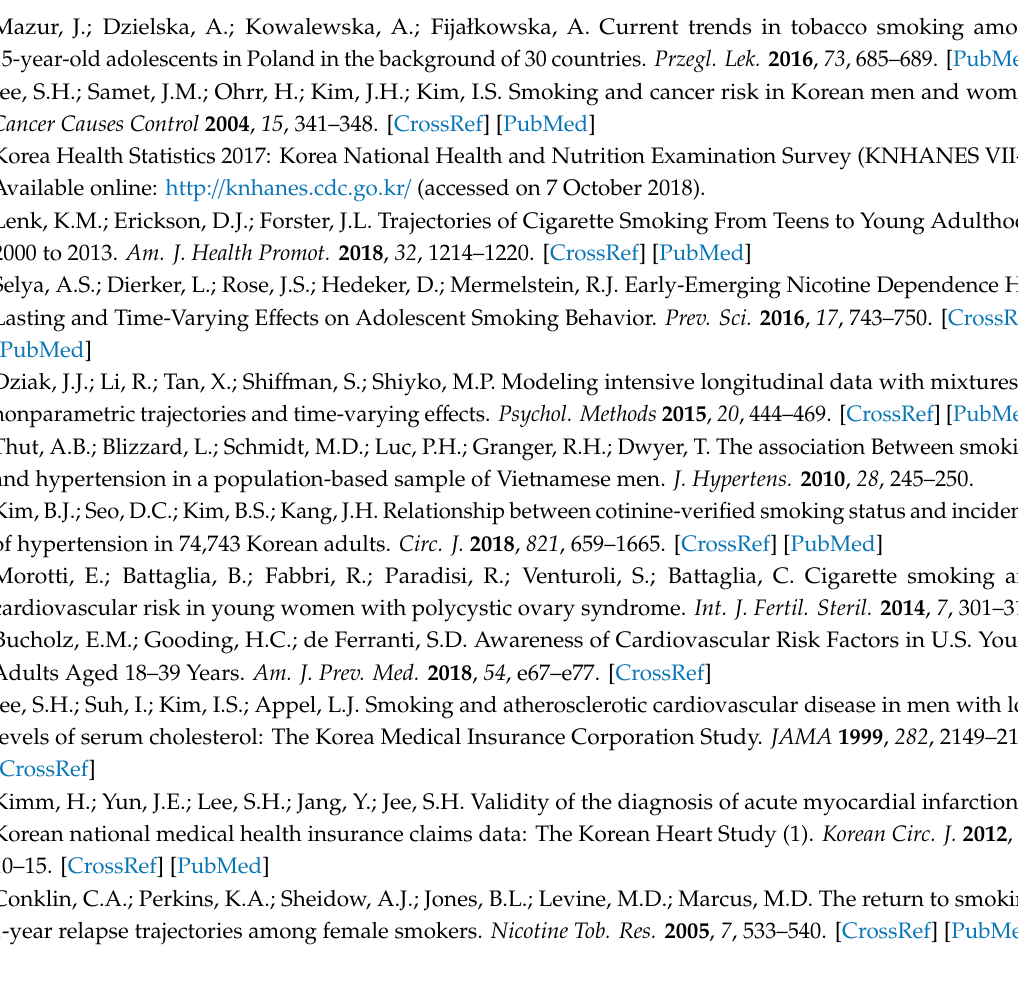
Table S1: Model selection; Table S2: Changes in smoking amount by trajectory group by year, 1992–2004; Figure S1. Trajectory group of smoking amount for 8 models; Figure S2. Flow chart of participants in the study; Figure S3. Illustration of the study